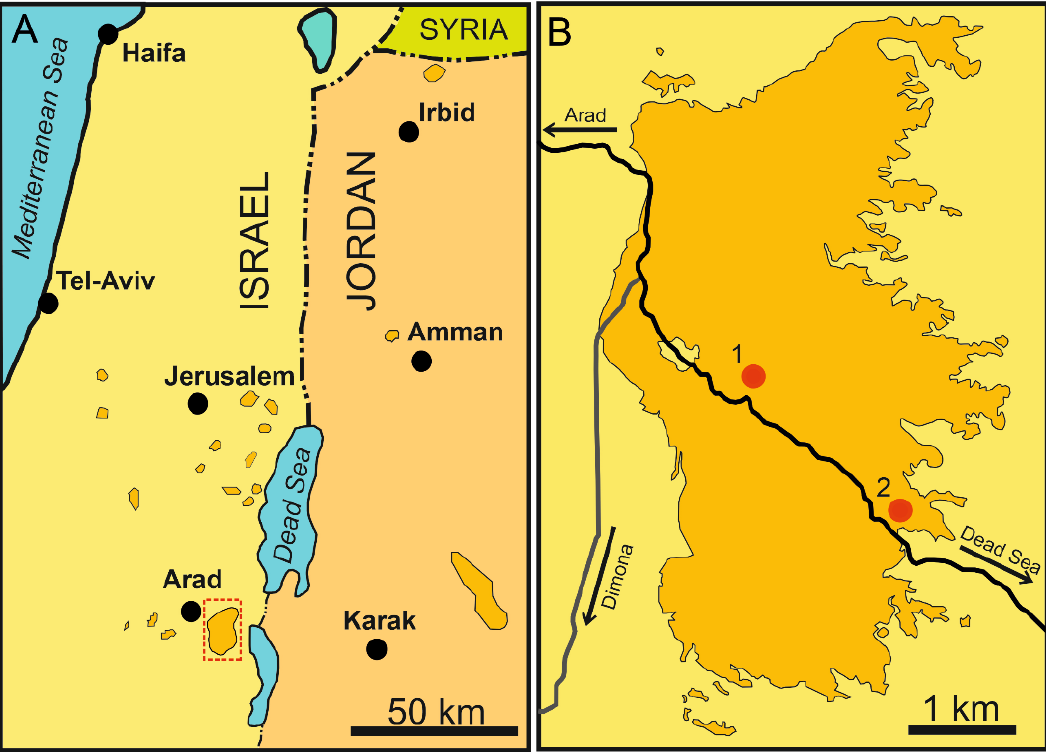
Figure 1. ( A ) Schematic map of the Middle East with outcrops of Hatrurim Complex (dark-yellow). The framed part is magnified in B. ( B ) Schematic map of the Hatrurim Basin. The sampling places of rankinite paralavas are marked by red circles—1. Gurim Anticline, 2. Zuk Tamrur (modified after Reference [20]).